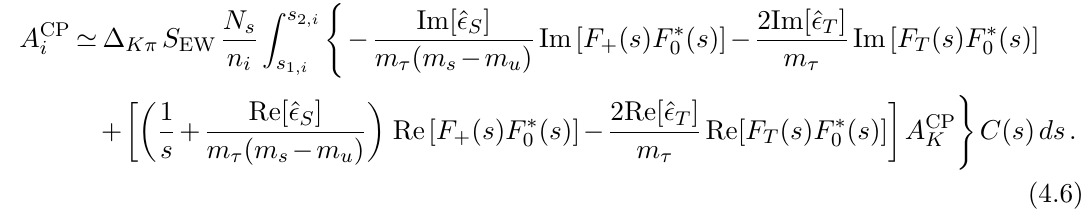
Figure 1 . Numerical relation between cos θ and cos ψ for three fixed values of (black solid line), 1 . 2 (red dashed line), and 1 . 6 GeV (blue dot-dashed line),